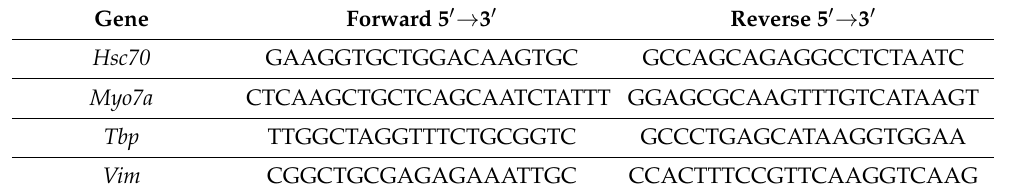
Table 2. List of primers used in qRT-PCR